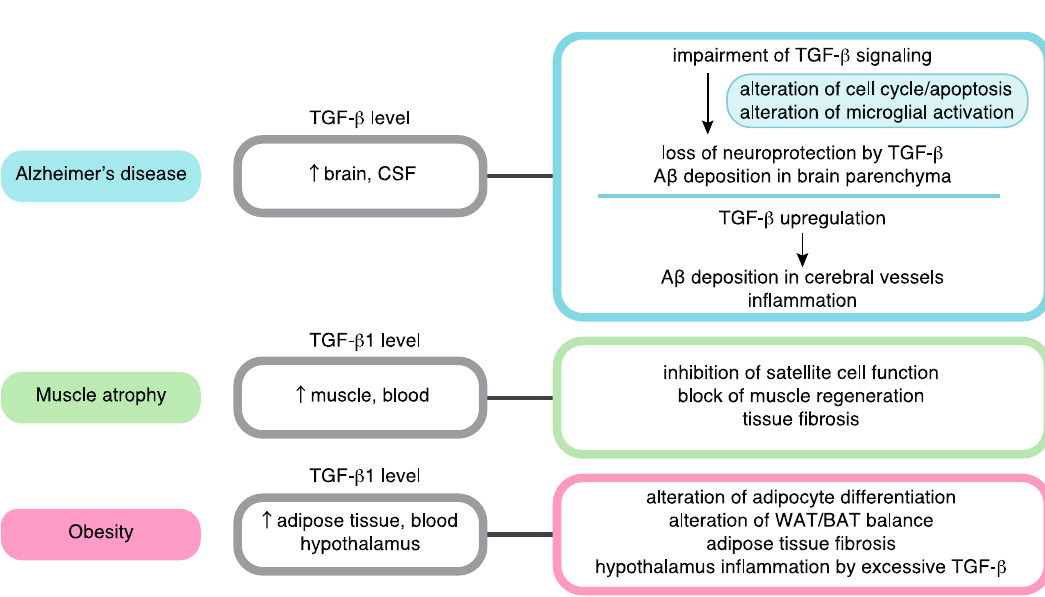
Figure 2. TGF- β signaling in aging-related disease pathology. Roles in Alzheimer’s disease, muscle atrophy, and obesity are summarized.